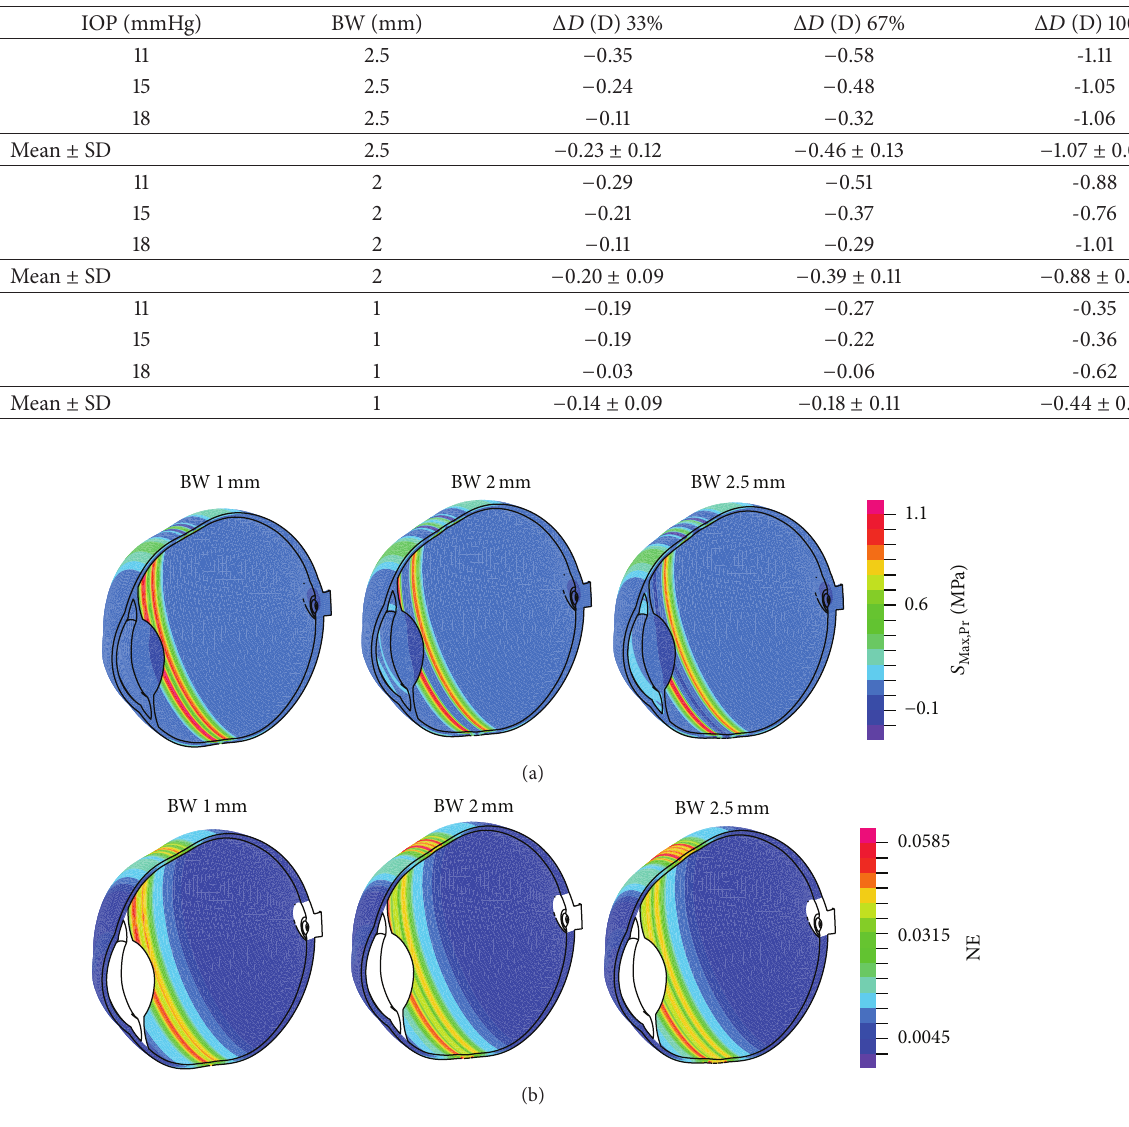
Figure 4: Stress and strain distribution in the model after surgery. The three upper images show the maximal principal stress ( 𝑆 Max , Pr ) distribution (in MPa) in the model of the eye after the simulation of 1, 2, and 2.5 mm wide bands at an IOP of 15 mmHg. The images at the bottom show the logarithmic strain NE (nondimensional) in the model after the simulation of the surgery for the same three